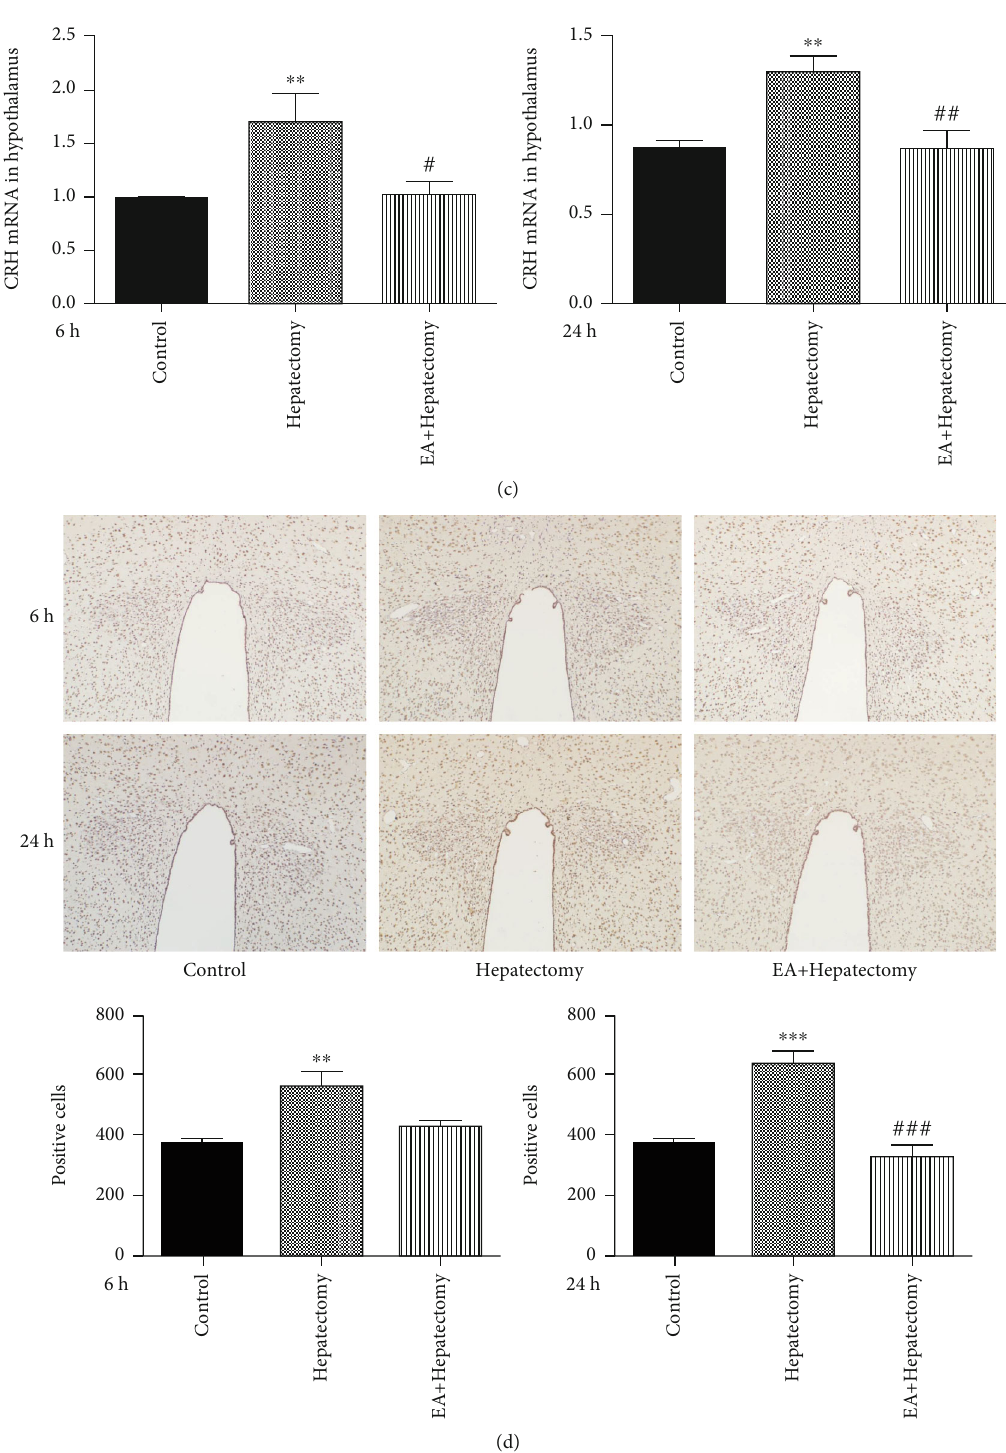
Figure 1: Peripheral serum CRH, ACTH, and CORT levels were detected by the radioimmunoassay after rats su ff ering surgical trauma and CRH expression in the PVN of rats. (a) The peripheral serum CRH, ACTH, and CORT levels in the control, hepatectomy, and EA +hepatectomy groups at 6h and 24 h after hepatectomy, respectively. (b) Representative bands of CRH protein levels and quanti fi cation of CRH protein levels and (c) CRH mRNA levels at 6 h and 24h in the control, hepatectomy, and EA+hepatectomy groups after hepatectomy. (d) Representative pictures of CRH mRNA-positive cells and quanti fi cation of CRH mRNA-positive cells in the control, hepatectomy, and EA+hepatectomy groups at 6h and 24h after hepatectomy. Data are presented as the mean ± SEM ( n = 4 ). ∗ vs. control group ( p < 0 : 05 ): ∗∗ p < 0 : 01 , ∗∗∗ p < 0 : 001 ; # vs. hepatectomy group ( p < 0 : 05 ): ## p < 0 : 01 , ### p < 0 : 001